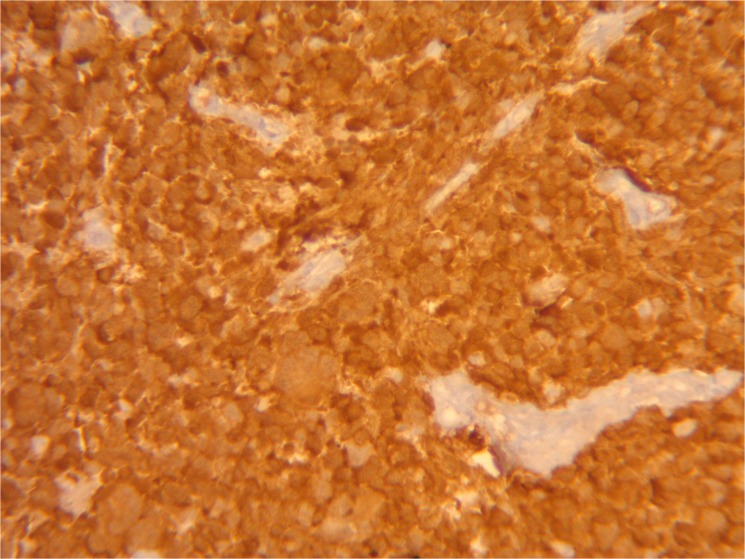
IDH1 immunohistochemistry in patient 6.Strong immunolabelling of 100% of tumor cells; negativity on vessels.